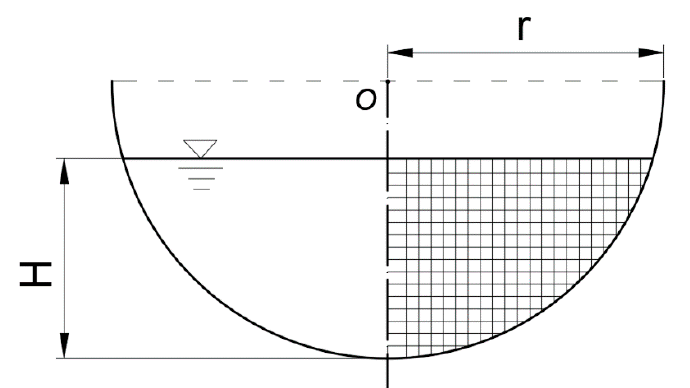
Figure 4. Schematic diagram of measurement points in the experiment (take semicircular channel as an example).